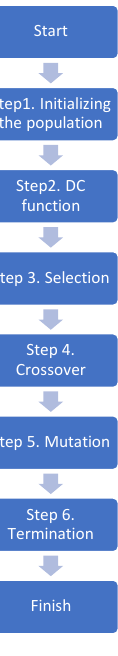
Figure 2. The flowchart of the model solved by GA .